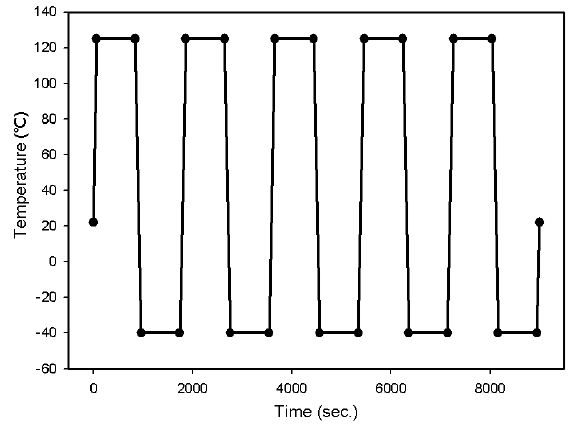
Figure 4. Loading conditions for thermal shock testing. Table 1. Properties of the study materials.